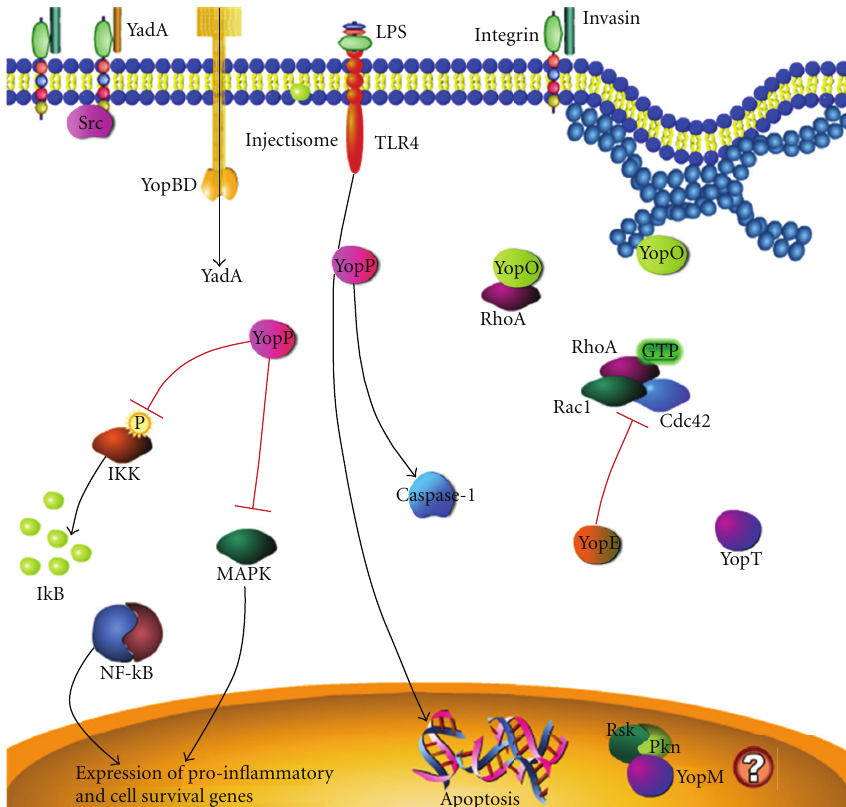
Figure 3: Mechanisms of action of the enteropathogenic yersiniae Ysc T3SS e ff ectors (Yops) on host cell signaling and survival. As shown, membrane-bound Yersinia Yad and invasin proteins bind host cell β 1-integrins, bringing the bacteria into close proximity to the host cell thereby facilitating insertion of the T3SS injectisome needle-like structure into the targeted host cell. Yops are then translocated across the host plasma membrane and into the cytoplasm, where they interact with the cytoskeleton and host cell signaling molecules. YopO/YpkA interacts directly with the cytoskeleton, as well as the small GTPase signaling molecules, RhoA, Rac1, and Cdc42. YopE inhibits the activities of RhoA, Rac1, and Cdc42. YopP/J promotes LPS-induced host cell apoptosis and directly induces capsase-1 cleavage. YopP/J also inhibits mitogen-activated protein kinases (MAPK) and IKK-mediated NF- κ B activation, which prevents expression of proinflammatory and cell survival genes. YopM forms a complex with Rsk and Pkn in the host cell nucleus, which is believed to contribute to bacterial pathogenesis. The figure was produced using Pathway Builder 1.0, a cell signaling drawing tool provided through the Protein Lounge